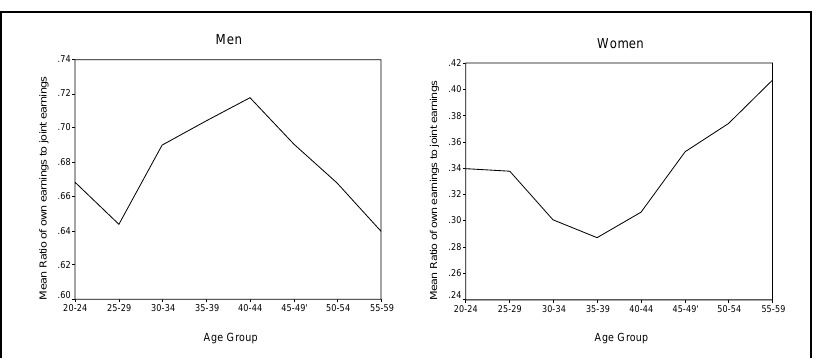
Figure 5. Mean ratio of own to joint earnings across age groups, partnered men and women aged 20 to